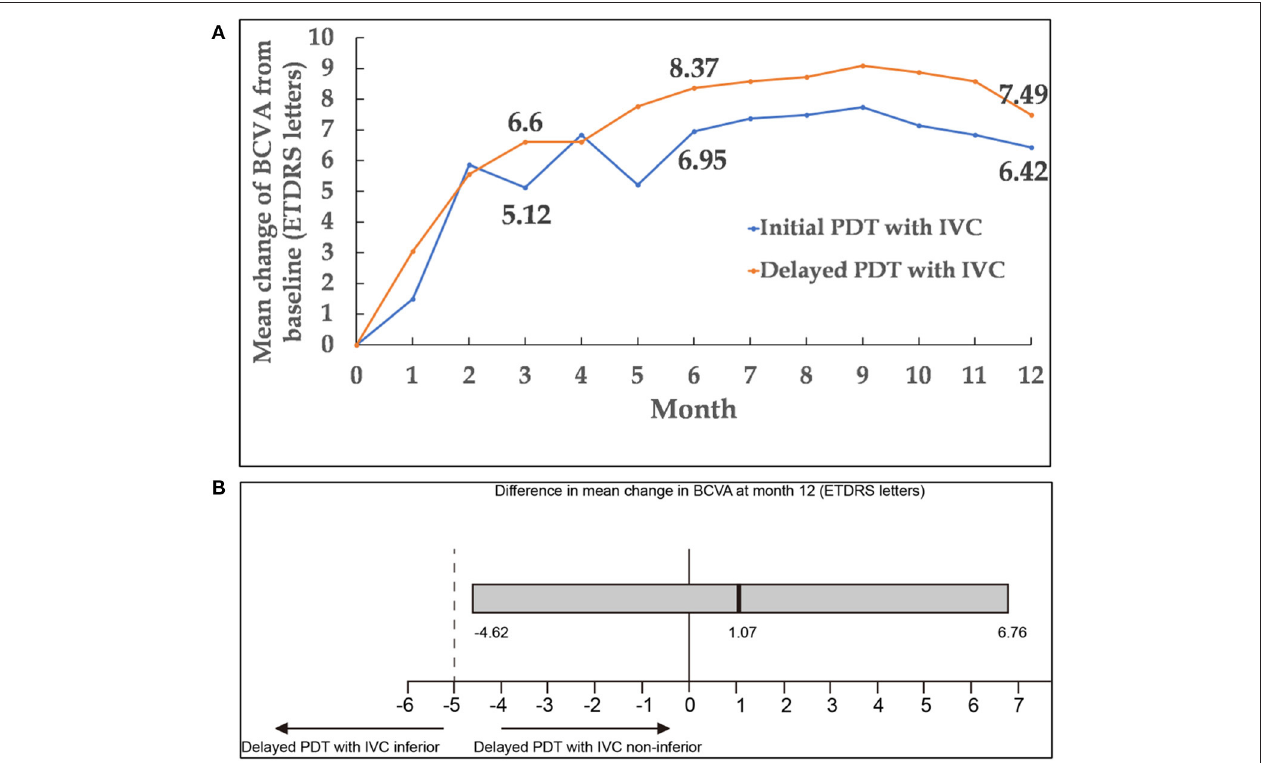
FIGURE 2 | (A) Mean change of BCVA from baseline to month 12. (B) Differences in BCVA change from baseline to month 12 between the two groups. The black vertical lines indicated the mean difference between the two groups, and the gray bar was the 95.0% CI. CI within − 5 and + 5 letters (dashed vertical lines) indicated that the two groups were equivalent. A lower limit of the 95.0% CI with a value above − 5 showed that delayed PDT combined with IVC was non-inferior compared with initial PDT combined with IVC. BCVA, best-corrected visual acuity; CI, confidence interval; PDT, photodynamic therapy; IVC, intravitreal injection of conbercept.